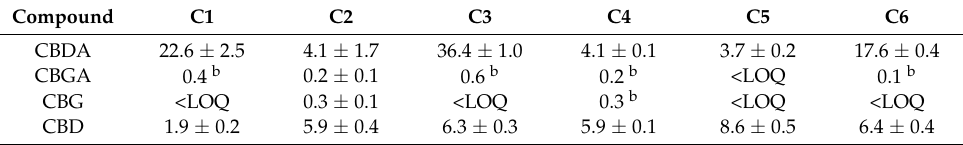
Table 2. Amount (mg/g) of the main non-psychoactive cannabinoids in hemp inflorescences a . Compound